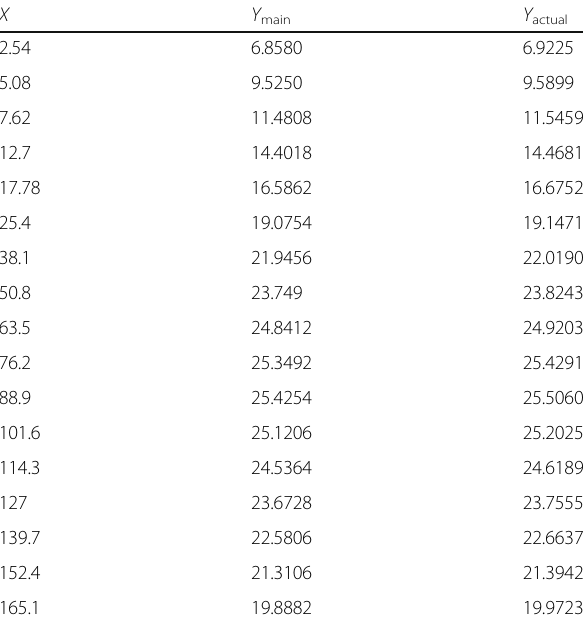
Table 10 The deviation percentage of the measured values to the values inserted on the plot X Y